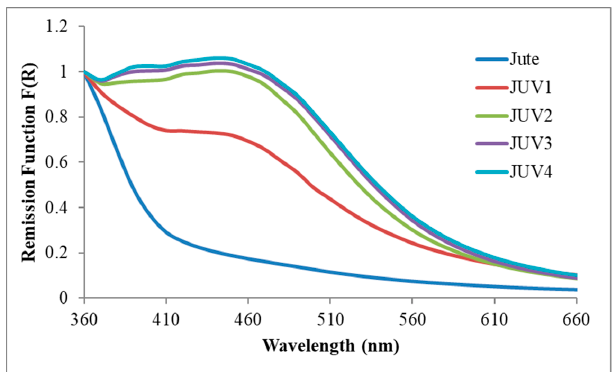
Figure 10. Normalized GSDR spectra of the jute fabric with Ag NPs using the UV photoreduction method and different AgNO 3 concentrations.